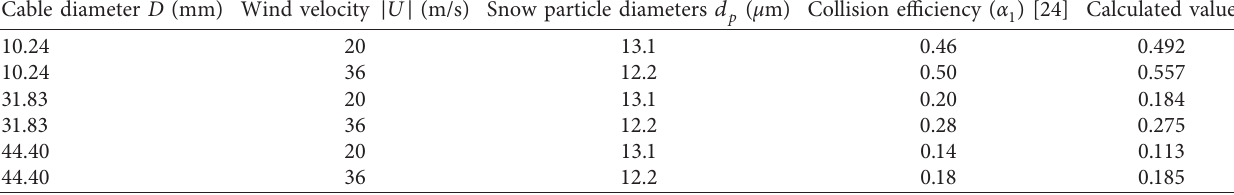
Table 1: Validation of the collision efficiency ( α → | ). ( | U